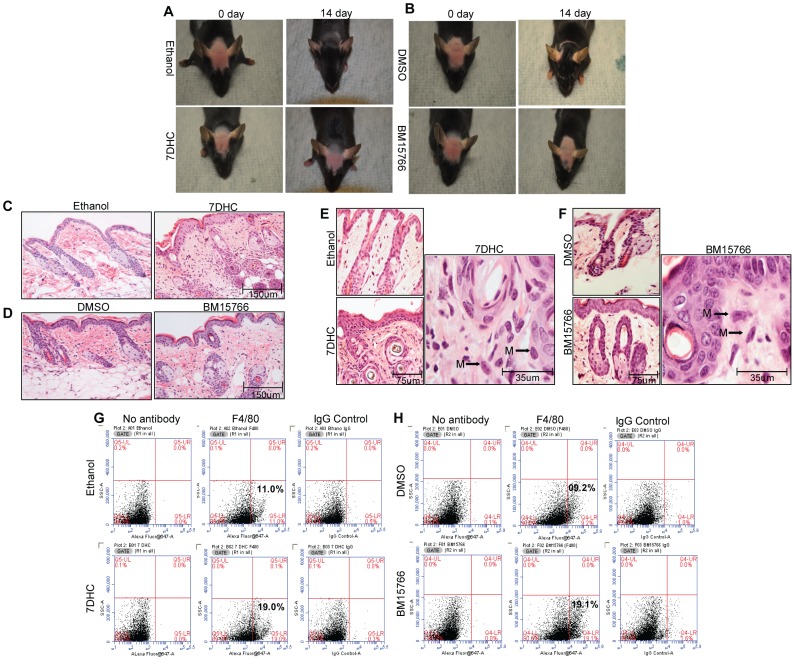
Sterol intermediates of cholesterol biosynthesis inhibit hair growth and activate the inflammatory response in C57BL/6J mice.(A) Topical 7-DHC and (B) BM15766 treatment inhibited hair growth compared with vehicle treatment (ethanol or DMSO). Hair growth was restored in vehicle-treated but not in 7-DHC and BM15766 treated mice. (C, D) Histology of mouse skin treated with ethanol, DMSO, 7-DHC and BM15766 (20X). H&E staining of vehicle-treated mice showed normal hair follicles and sebaceous glands. In contrast, H&E staining of mice treated with 7-DHC and BM15766 showed hyperkeratosis as well as dystrophic hair follicles and sebaceous glands. Scale bar = 50 µm. (E, F) H&E staining showed peri-follicular and inter-follicular inflammation in mouse skin that had been treated with 7-DHC (40×). At higher magnification (100×), infiltration of tissue histiocytes is observed. (G, F) A higher percentage of F4/80 cells was present in mouse skin treated with 7-DHC (Q5-LR) and BM15766 (Q4-LR) than in the vehicle-treated mouse skin. See also Figures S3 and S4.